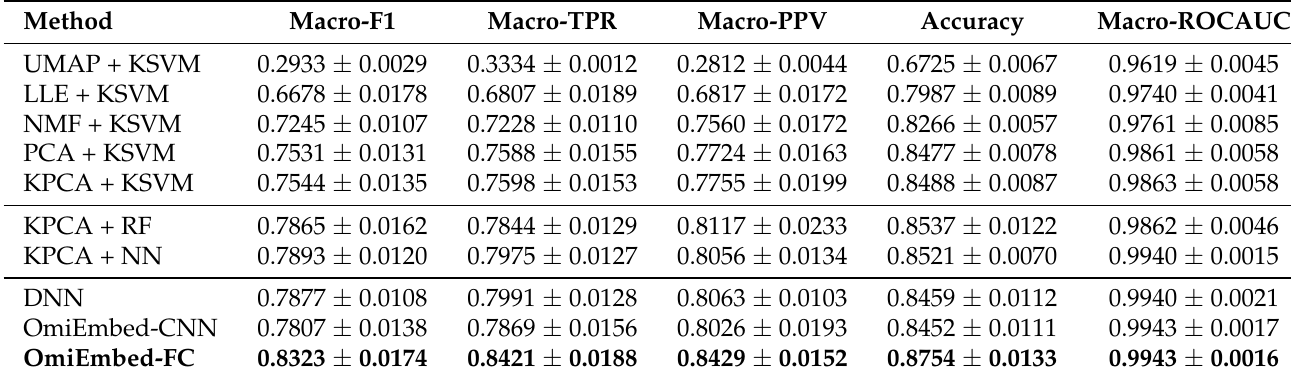
Table 2. The classification performance on the BTM dataset using the histopathological tumour type labels (2016 WHO classification) with 5-fold cross-validation, which was measured by macro-averaged F1 score (Macro-F1), macro-averaged true positive rate (Macro-TPR), macro-averaged positive predictive value (Macro-PPV), overall accuracy and macro-averaged area under the receiver operating characteristic curve